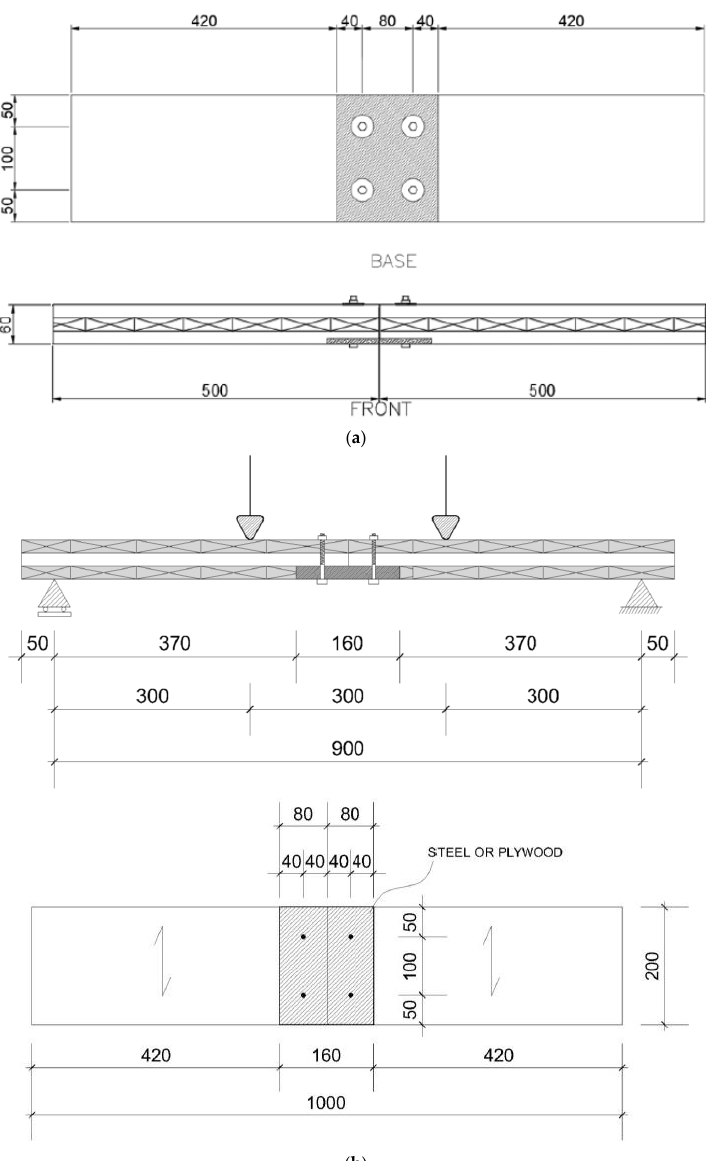
Figure 2. Bending test on single-splined CLT connection: ( a ) along the major axis and ( b ) along the minor axis.